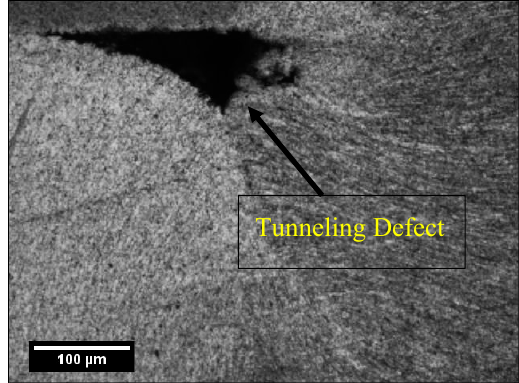
Figure 8. Tunnel defect in the welded joint.